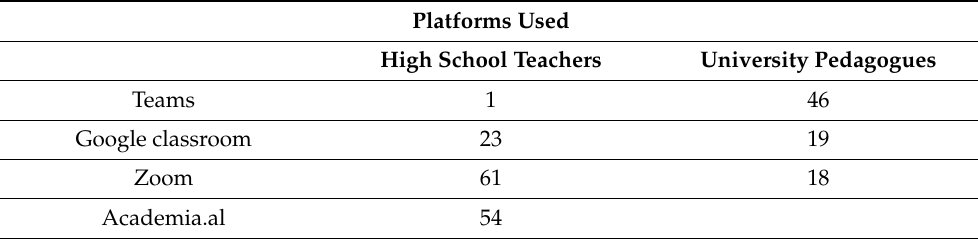
Table 2. Online teaching platforms.